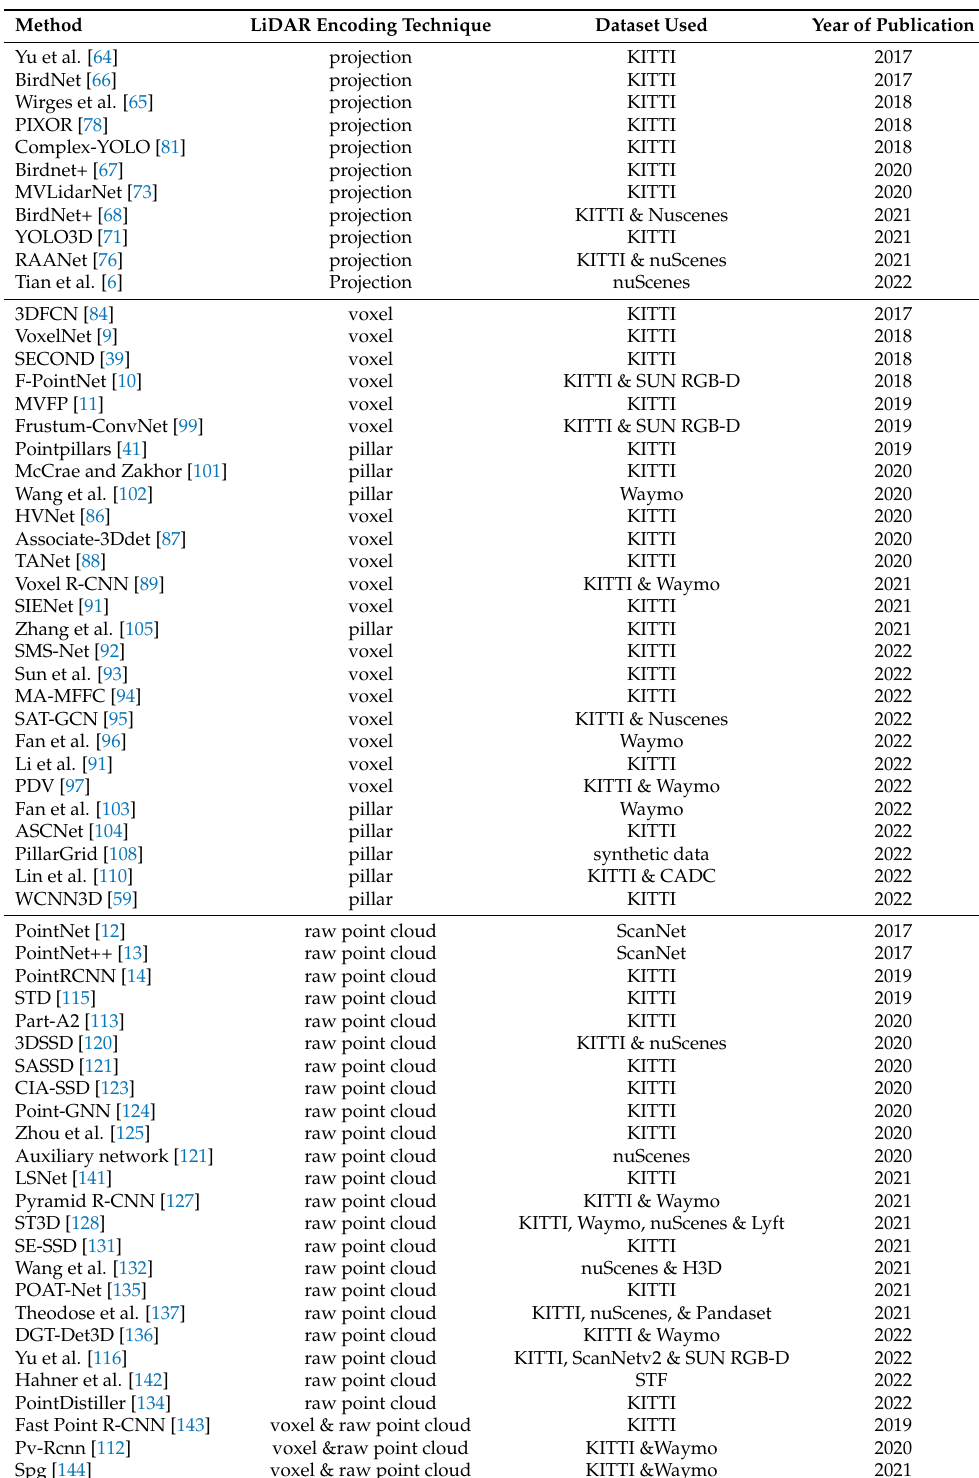
Table 2. Comparison of LiDAR-based 3D object-detection methods based on LiDAR encoding techniques, the dataset used, and year of publication. We categorized pillar representation in the volumetric encoding. Some methods use multiple datasets, but we report only datasets related to autonomous